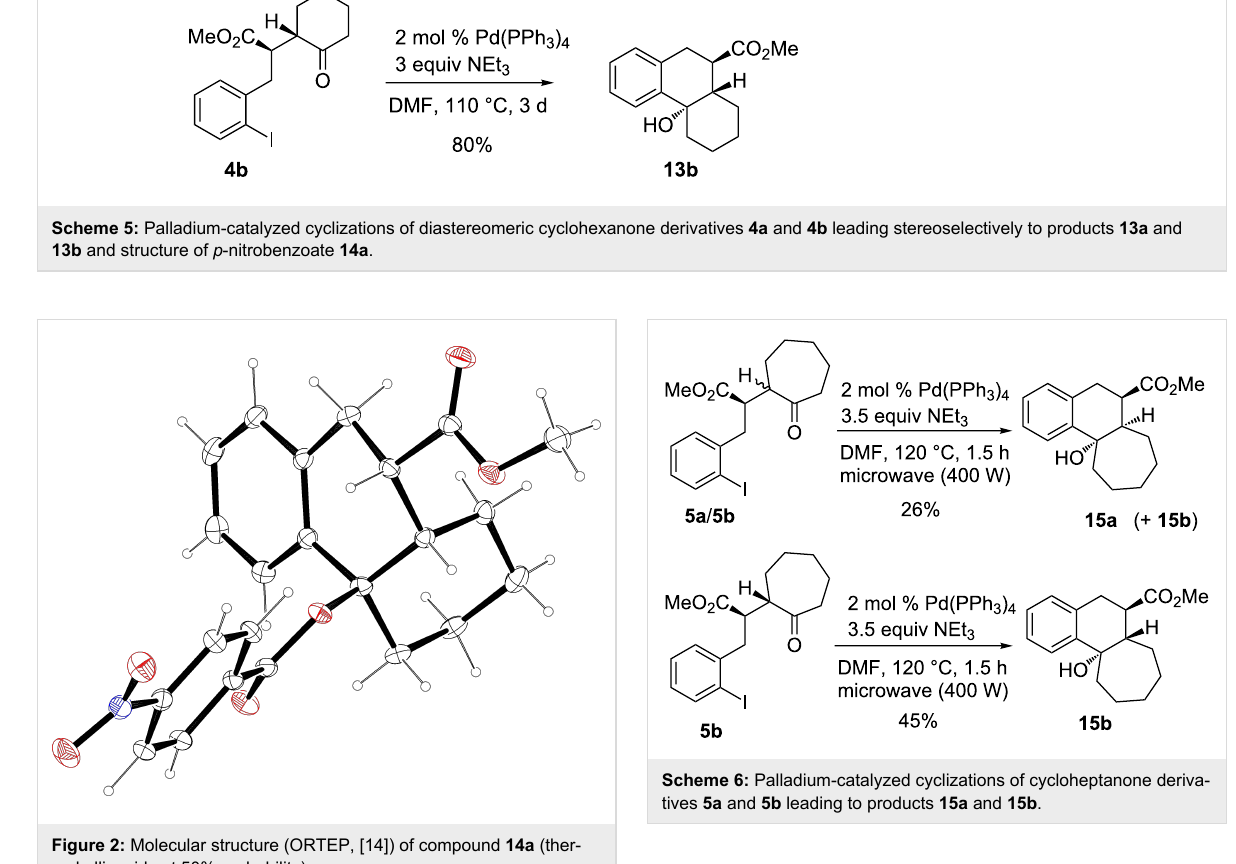
uration of compound 13b was tentatively assigned in analogy to its lower and higher homologs.